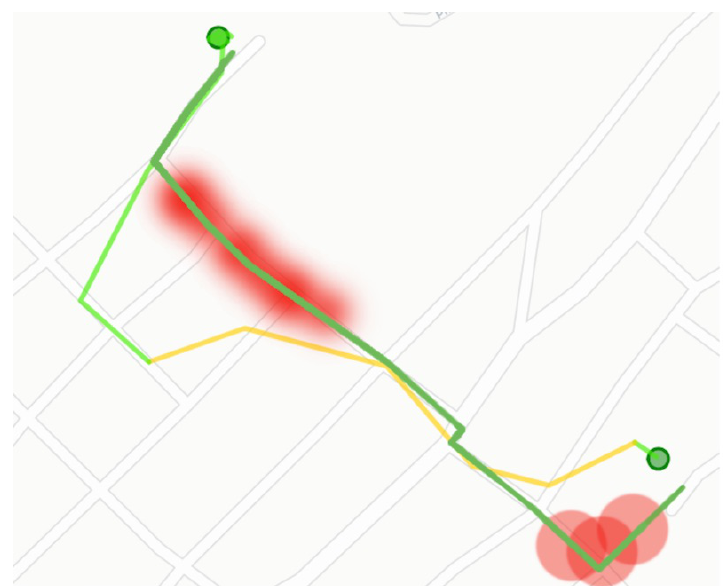
Figure 10. Insecure zones (shown in red) along the suggested routes make that people prefer to take alternative routes, even if they are somewhat